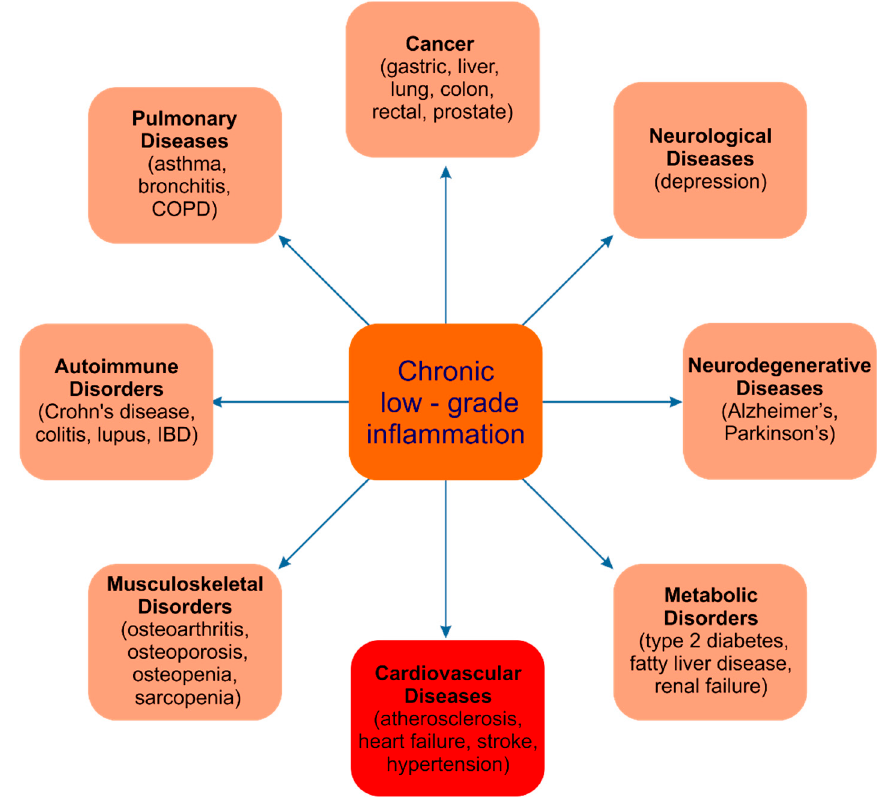
Figure 3. Diseases associated with chronic low-grade inflammation.